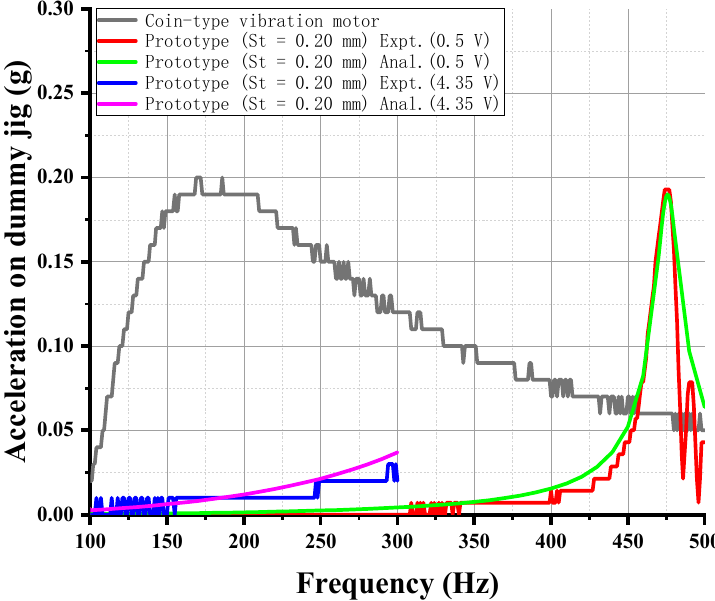
Figure 15. Acceleration comparison between coin-type vibration motor and prototype linear vibration motor.